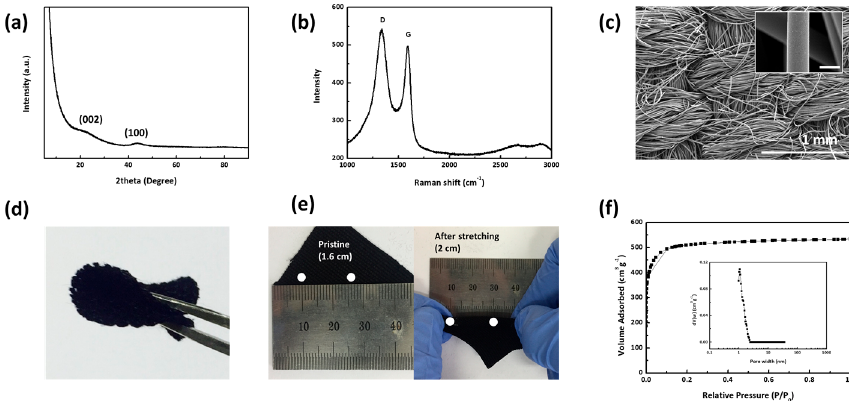
Figure 1. Structural characterization of the carbon cloth (CC). ( a ) XRD pattern; ( b ) Raman spectrum; ( c ) SEM images (scale bar of inset image: 10 μ m); photo images of ( d ) folded and ( e ) stretched CC support; ( f ) N 2 sorption isotherm; and ( f , inset) the corresponding pore size distribution calculated by the NLDFT method.